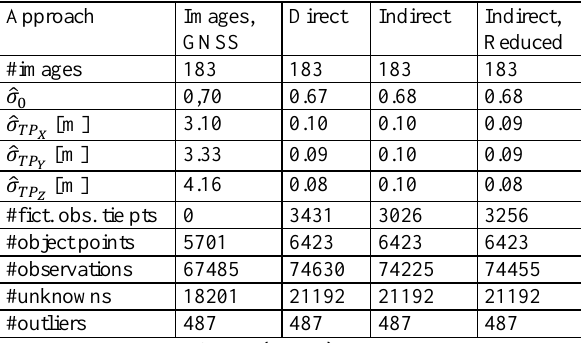
Table 2: Results of the (hybrid) adjustment on the test